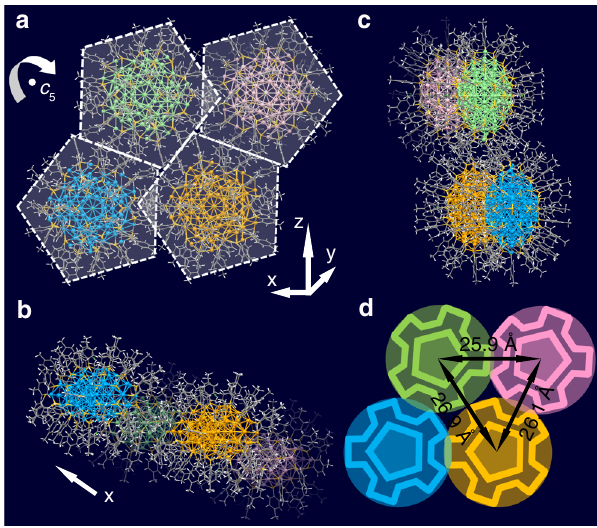
Fig. 4 The assembly of [Cu 72 Au 52 (SR) 55 ] + . a Four nearest pentagonal [Cu 72 Au 52 (SR) 55 ] + particles with tip-to-edge, edge-to-edge, and tip-to-tip interactions; b , c top and side views of the four interacting particles; d the “ quadruple-gear ” interlock diagram demonstrating the interactions among the four nearest